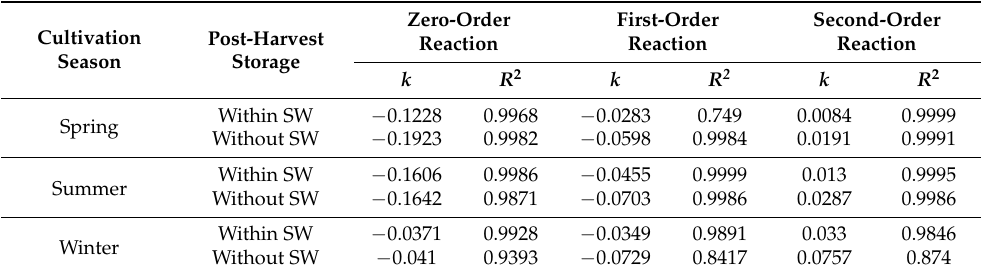
Table 1. The k and R 2 value for kinetics of total chlorophyll degradation on seagrape in different seasons during nine days of post-harvest